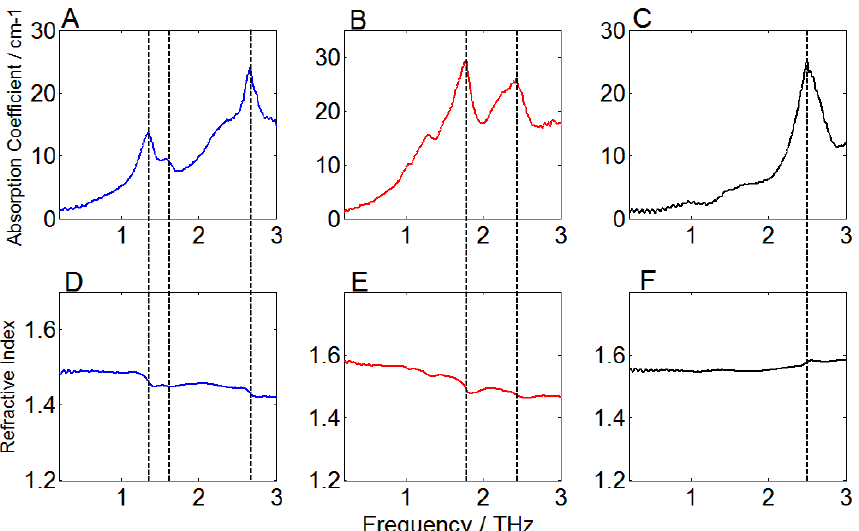
Figure 3. Absorption coefficients and refractive indexes of PGRs. ( A ) Absorption coefficient of 2,4-D; ( B ) absorption coefficient of CPPU; ( C ) absorption coefficient of IAA; ( D ) refractive index of 2,4-D; ( E ) refractive index of CPPU; ( F ) refractive index of IAA.